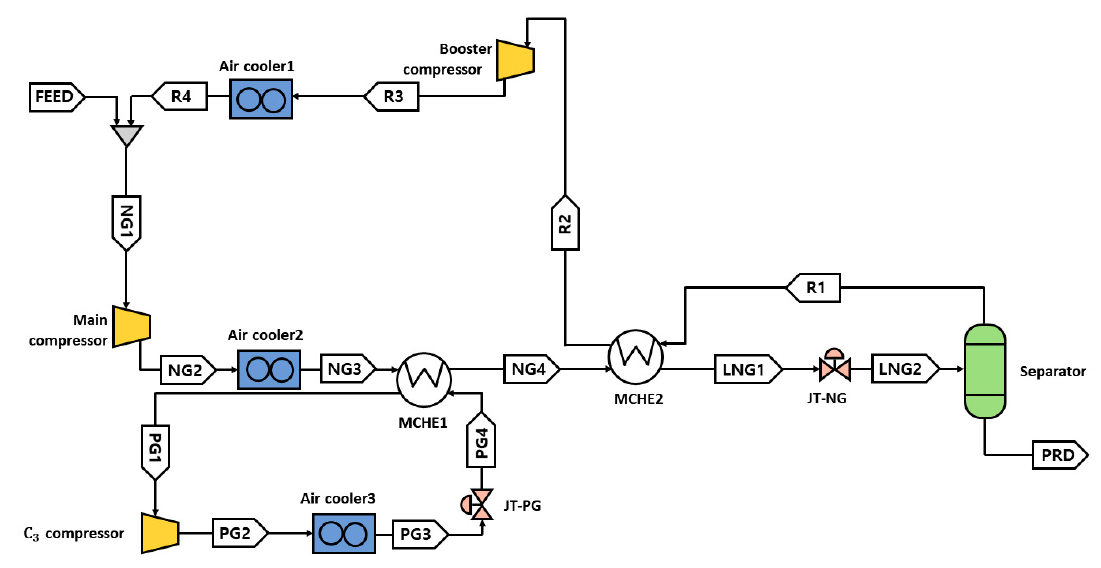
Figure 4. Process flow diagram of the propane pre-cooled self-refrigeration system.